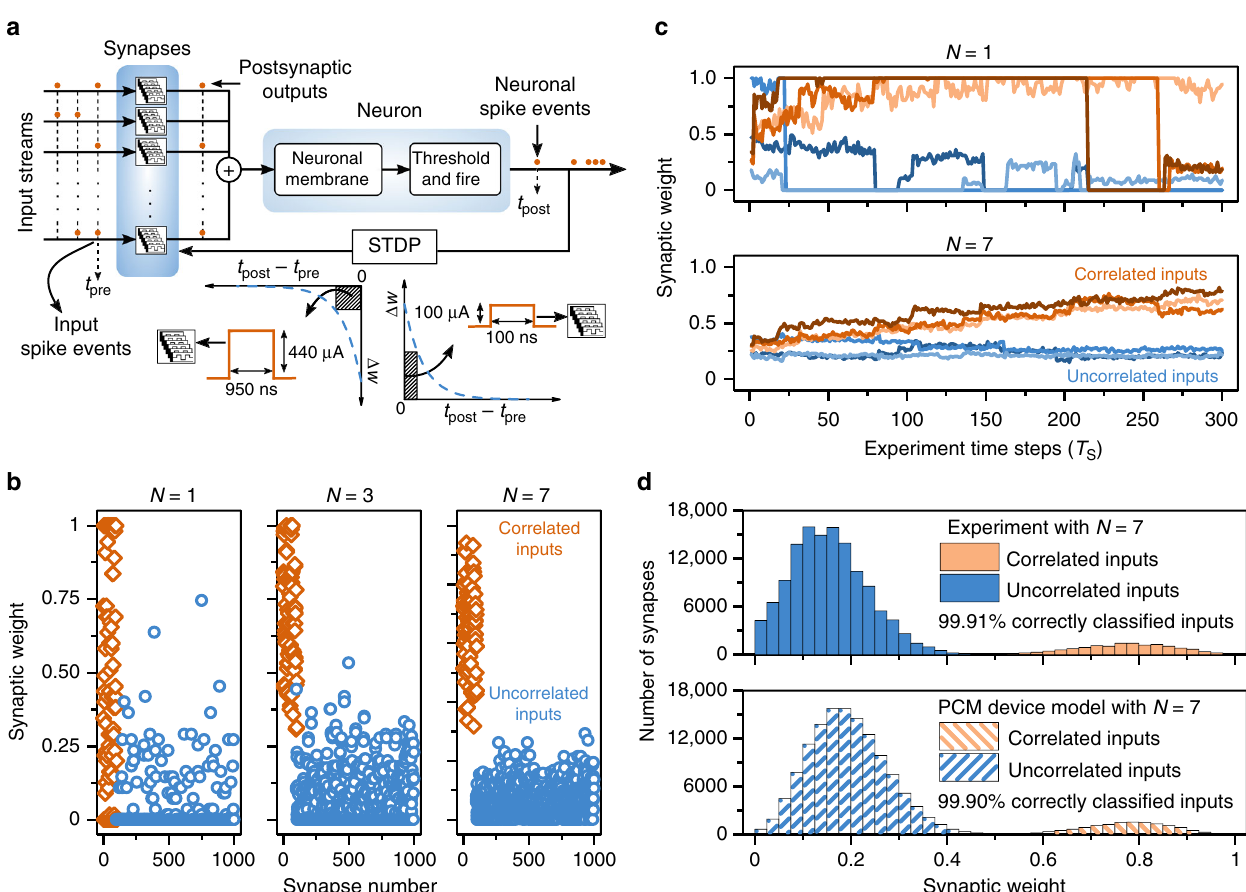
Fig. 5 Experimental demonstration of multi-memristive synapses used in a spiking neural network. a A spiking neural network is trained to perform the task of temporal correlation detection through unsupervised learning. Our network consists of 1000 multi-PCM synapses (in hardware) connected to one integrate-and- fi re (I&F) software neuron. The synapses receive event-based data streams generated with Poisson distributions as presynaptic input spikes. 100 of the synapses receive correlated data streams with a correlation coef fi cient of 0.75, whereas the rest of the synapses receive uncorrelated data streams. The correlated and the uncorrelated data streams both have the same rate. The resulting postsynaptic outputs are accumulated at the neuronal membrane. The neuron fi res, i.e., sends an output spike, if the membrane potential exceeds a threshold. The weight update amount is calculated using an exponential STDP rule based on the timing of the input spikes and the neuronal spikes. A potentiation (depression) pulse with fi xed amplitude is applied if the desired weight change is higher (lower) than a threshold. b The synaptic weights are shown for synapses comprising N = 1, 3, and 7 PCM devices at the end of the experiment (5000 time steps). It can be seen that the weights of the synapses receiving correlated inputs tend to be larger than the weights of those receiving uncorrelated inputs. The weight distribution shows a clearer separation with increasing N . c Weight evolution of six synapses in the fi